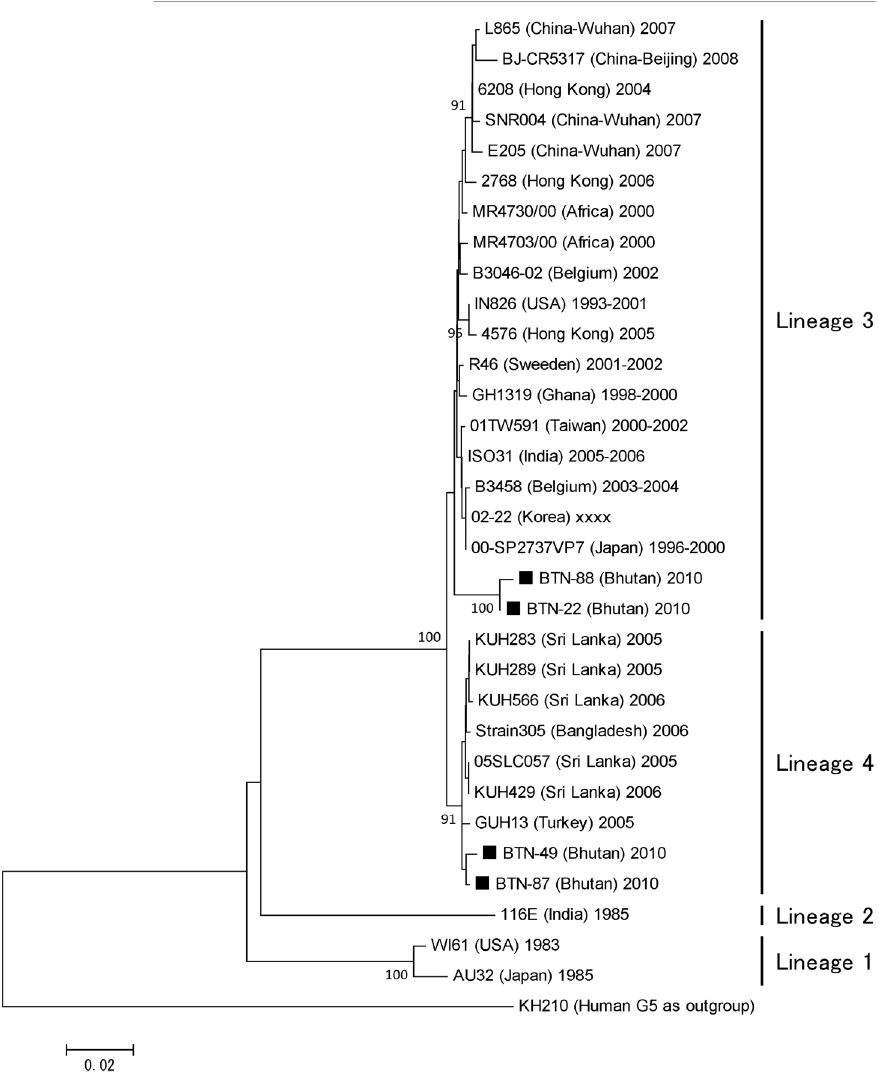
Figure 4. Phylogenetic tree constructed base on the deduced amino acid sequences of the VP7 genes of G9 strains. Bhutanese strains are indicated by black squares, which are followed by the strain numbers. Human rotavirus KH210 (G5) was used as an outgroup. The numbers adjacent to nodes represent the bootstrap values; values , 70% are not shown. The scale bar shows the genetic distance, which is expressed as amino acid substitutions per site. The DNA Data Bank of Japan/European Molecular Biology Laboratory/GenBank accessions numbers are: AB905463 (rotavirus strain BTN-22), AB905464 (BTN-49), AB905465 (BTN-87), and AB905466 (BTN-88).